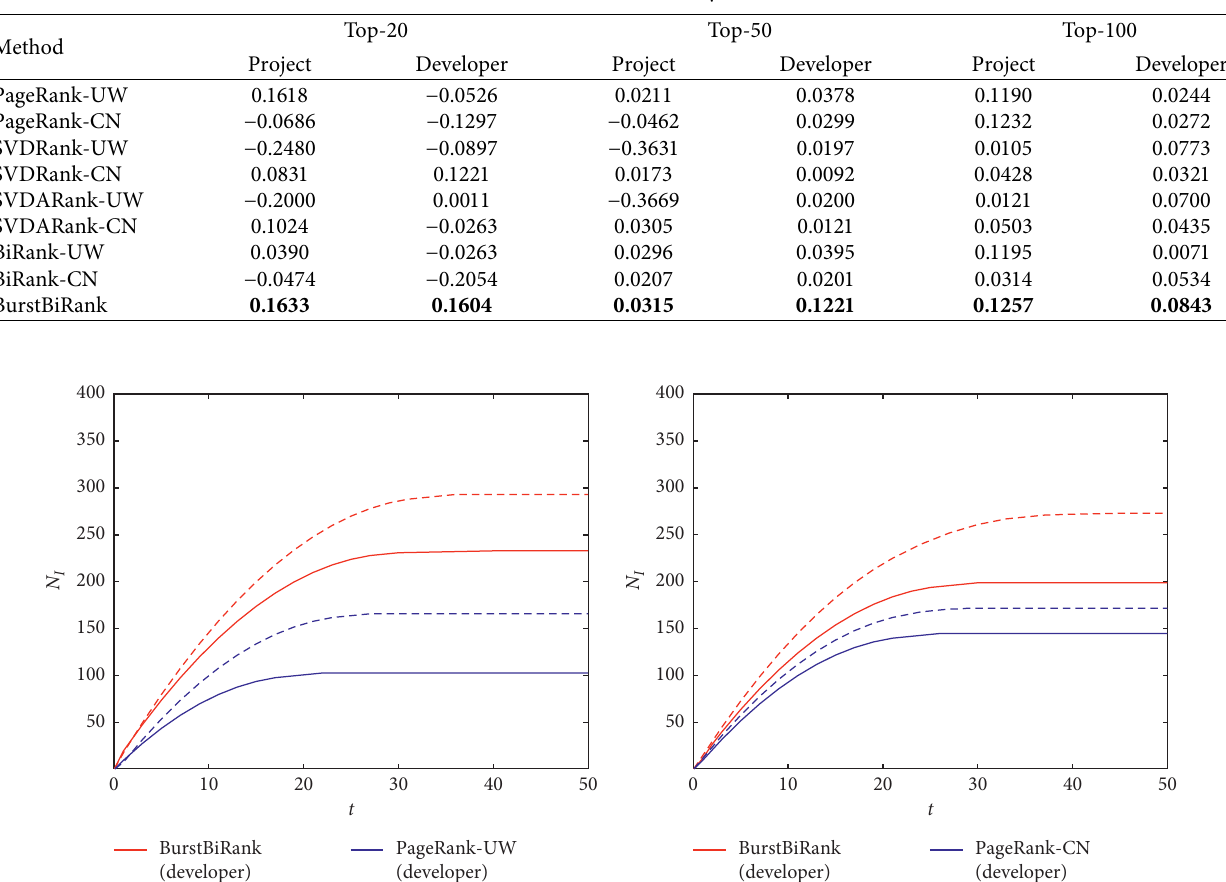
Table 3: Correlation